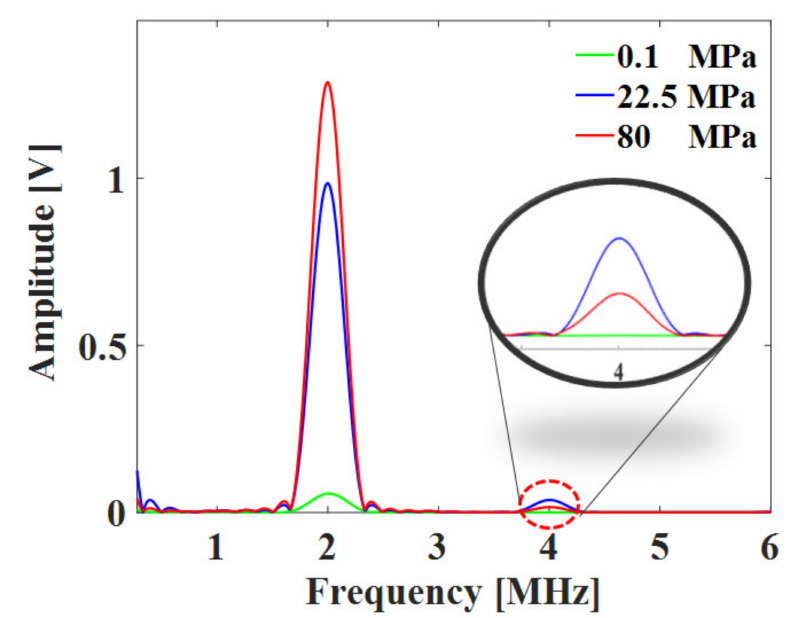
Figure 9. Received signal for specimen 2 at 22.5 MPa.